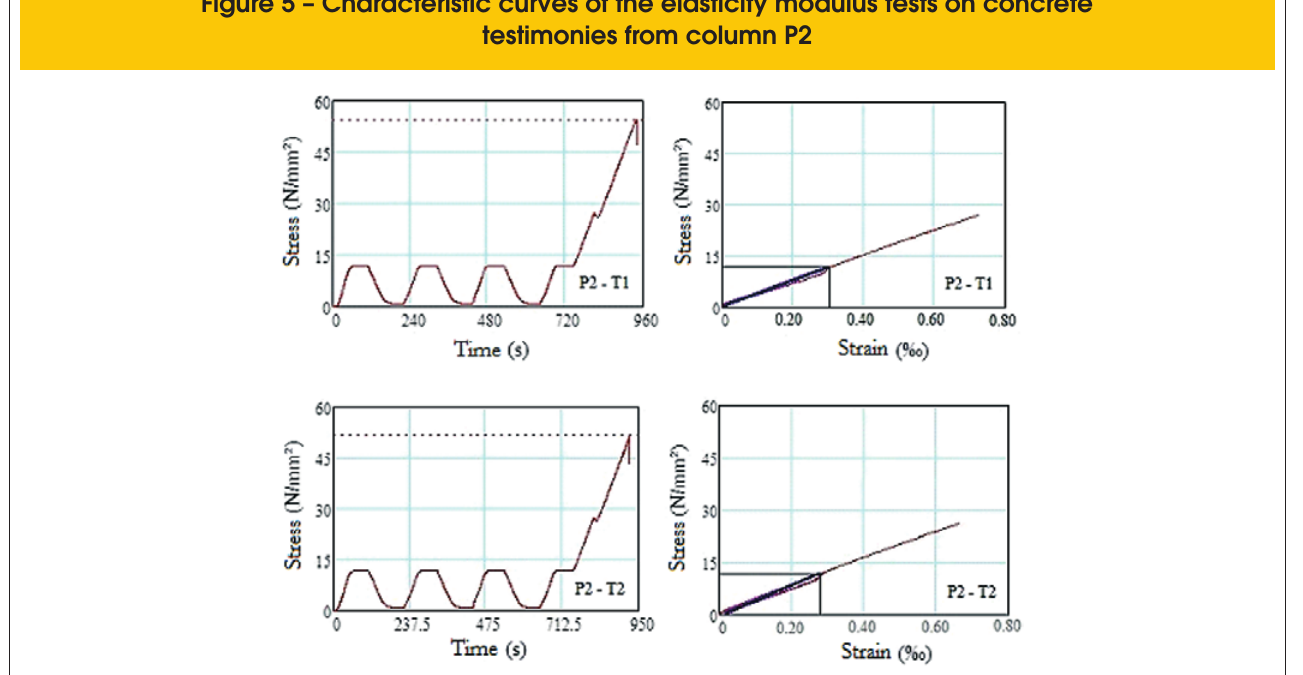
Figure 5 – Characteristic curves of the elasticity modulus tests on concrete testimonies from column